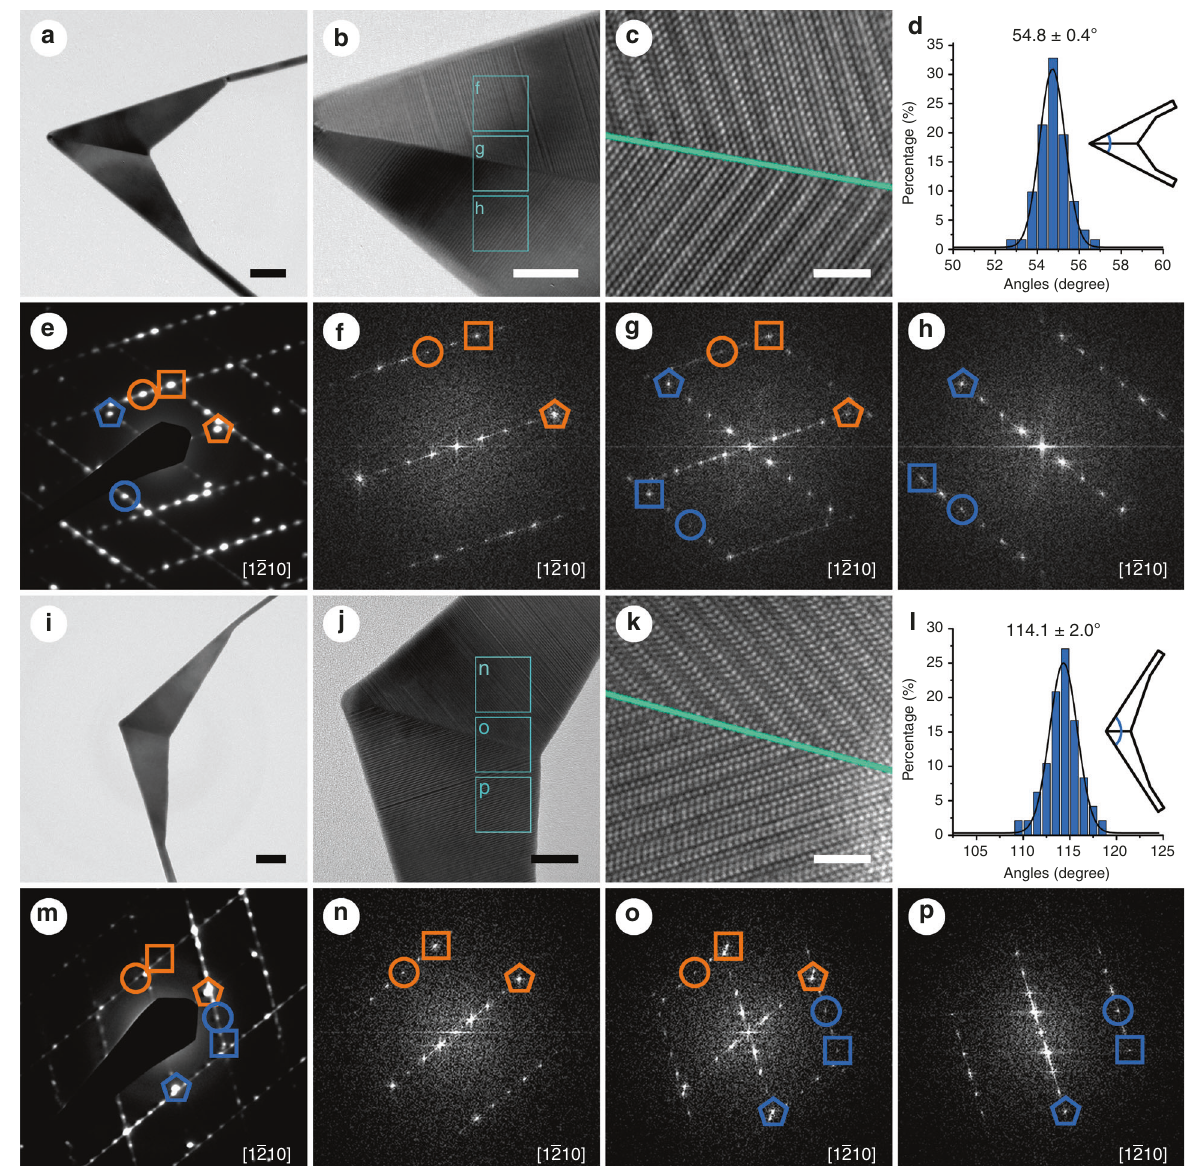
Fig. 2 Structural characterizations of acute-angled and obtuse-angled twinned Au nanokites. a Transmission electron microscopy (TEM) image of an acute- angled twinned nanokite and e the corresponding selected area electron diffraction (SAED) pattern. b High-magni fi cation TEM image of the acute-angled twinned Au nanokite with marked areas and f – h their corresponding fast Fourier transform (FFT) patterns. (0 0 0 4), (1 0 (cid:1) 1 0), and (1 0 (cid:1) 1 2) spots of 4H phase are marked with pentagons, circles, and squares, respectively. The orange and blue represent different 4H sub-crystals. c High-resolution TEM (HRTEM) image of the twin boundary of the acute-angled twinned nanokite. The twin boundary is marked in turquoise line. d Angle distribution histogram of acute-angled twinned nanokites and a nanokite model showing the measured angle. i TEM image of an obtuse-angled twinned nanokite and m the corresponding SAED pattern. j High-magni fi cation TEM image of the obtuse-angled twinned Au nanokite with marked areas and n – p their corresponding FFT patterns. k HRTEM image of the twin boundary of the obtuse-angled twinned nanokite. The twin boundary is marked in turquoise line. l Angle distribution histogram of obtuse-angled twinned nanokites and a nanokite model showing the measured angle. Scale bars, a , i 50 nm; b , j 20 nm; c , k 2 (cid:1) For the twinned Au nanokite with the {1 0 1 2} twinning plane, the model was built by seamlessly merging two pieces of 4H-phase (cid:1) sub-crystals with {1 0 1 2} plane, in which the two 4H-phase sub- (cid:1) crystals share the {1 0 1 2} twinning plane and are mirror images of each other (Fig. 3c, Supplementary Fig. 13). In a similar process, (cid:1) the model for twinned Au nanokite with the {1 0 1 6} twinning plane can be built as well (Fig. 3d, Supplementary Fig. 14). The atomic models match well with the corresponding HAADF-STEM images (Supplementary Fig. 15). Further calculation also reveals